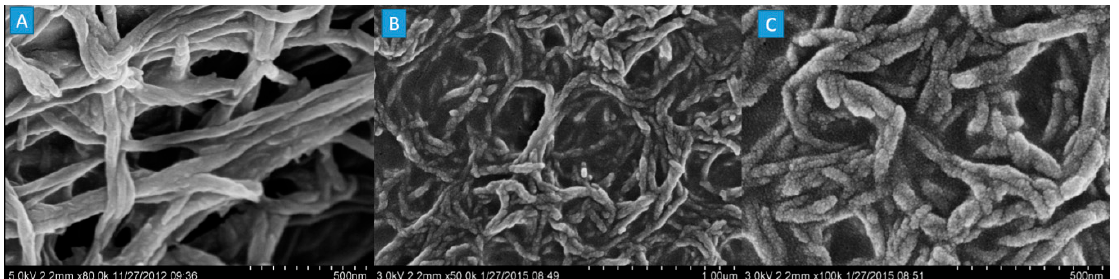
Figure 3. Representative SEM images of series of PANI nanocomposites (( A ) Sample 4; ( B,C ) Sample 1).